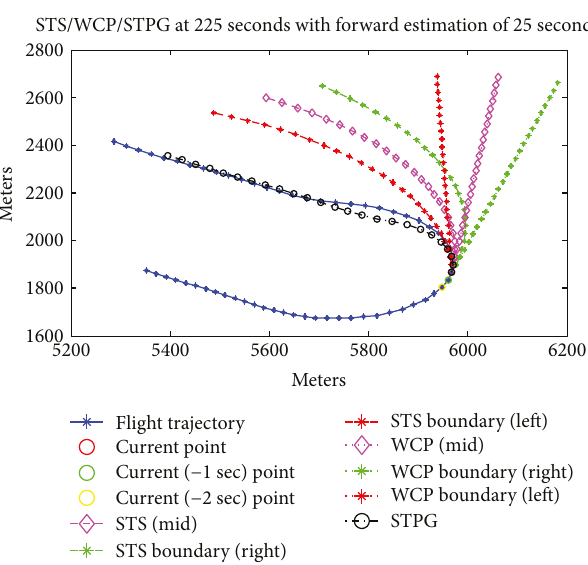
Figure 13: STPG versus STS versus WCP fl ight estimation at 225 seconds for UAV fl ight